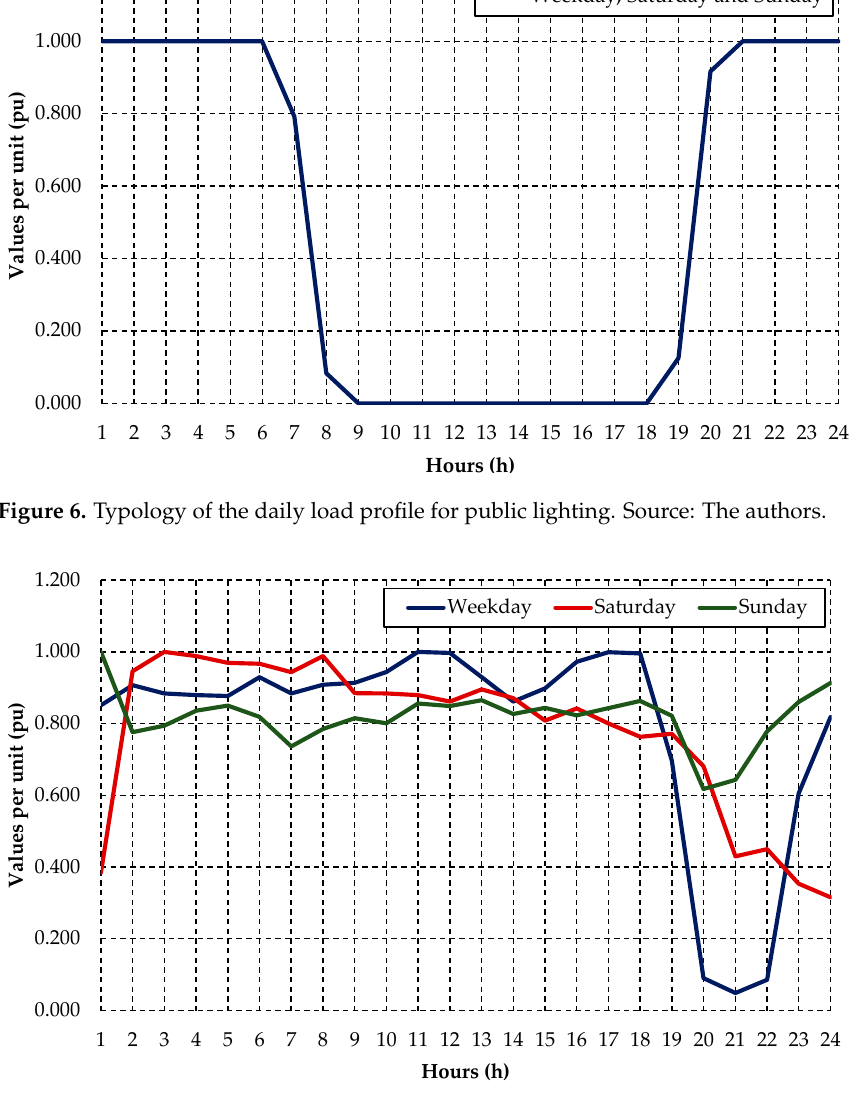
Figure 7. Typology of the daily load profile for an irrigator customer. Source: The authors.